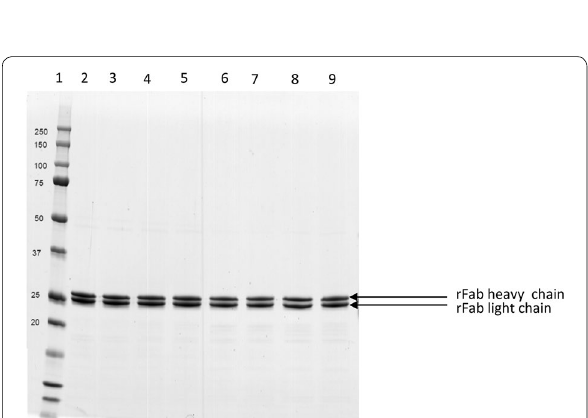
Fig. 4 SDS-PAGE analysis of rFabs from each of the eight bioreactors in the DOE optimization study. The SDS-PAGE samples were collected at day 18 of the cell culture. Lane 1 shows the molecular weight markers. Lanes 2 through 9 represent bioreactors 1 through